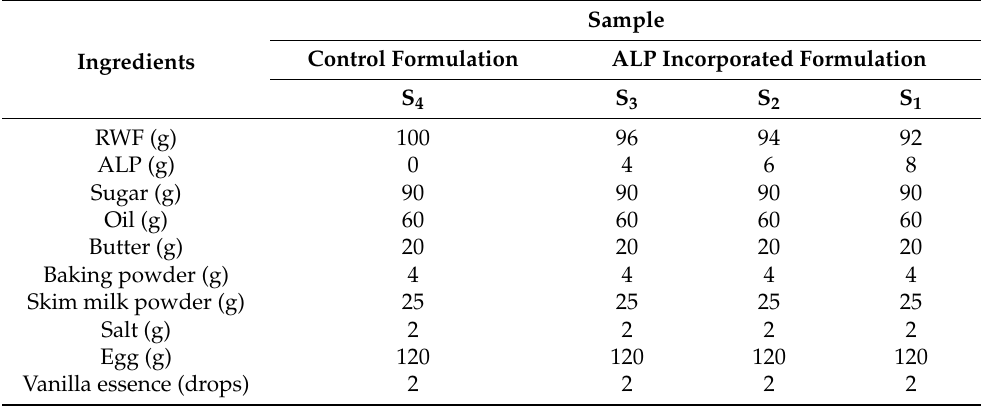
Table 1. Basic formulation for the preparation of plain cakes (on 100 g flour